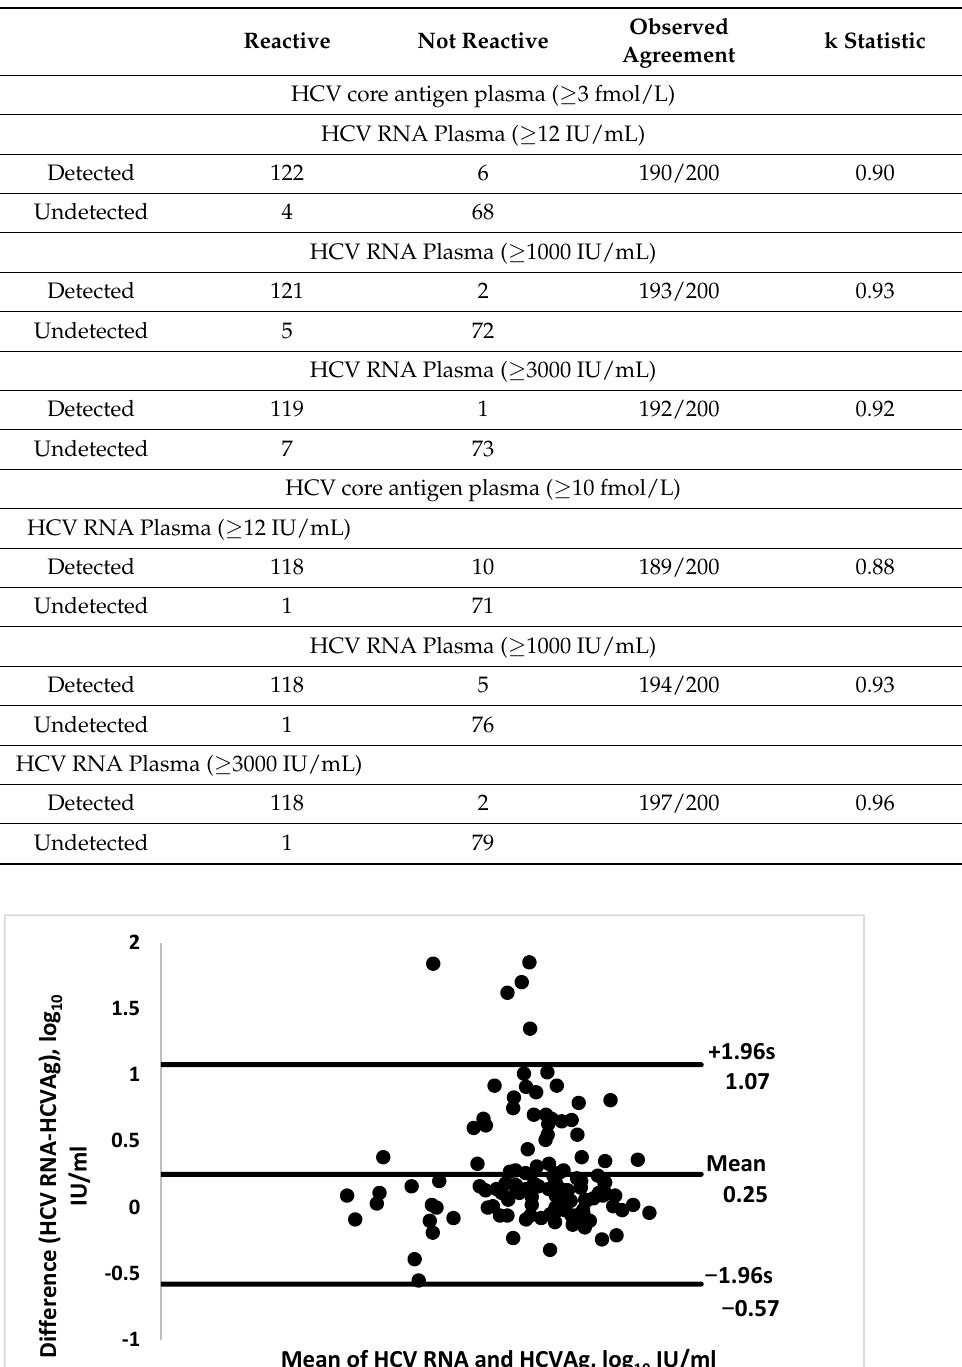
Table 3. Sensitivity and specificity of HCV core antigen plasma ( ≥ 10 fmol/L) compared with dif- ferent HCV RNA thresholds.